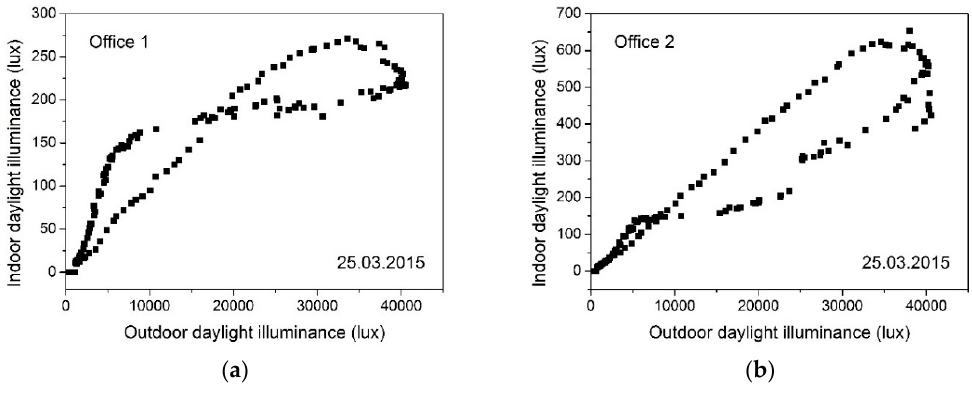
Figure 9. Relationships between internal and external illuminance of daylight measured by the weather station on a sunny day (25 March 2015) for ( a ) Office 1 and ( b ) Office 2.